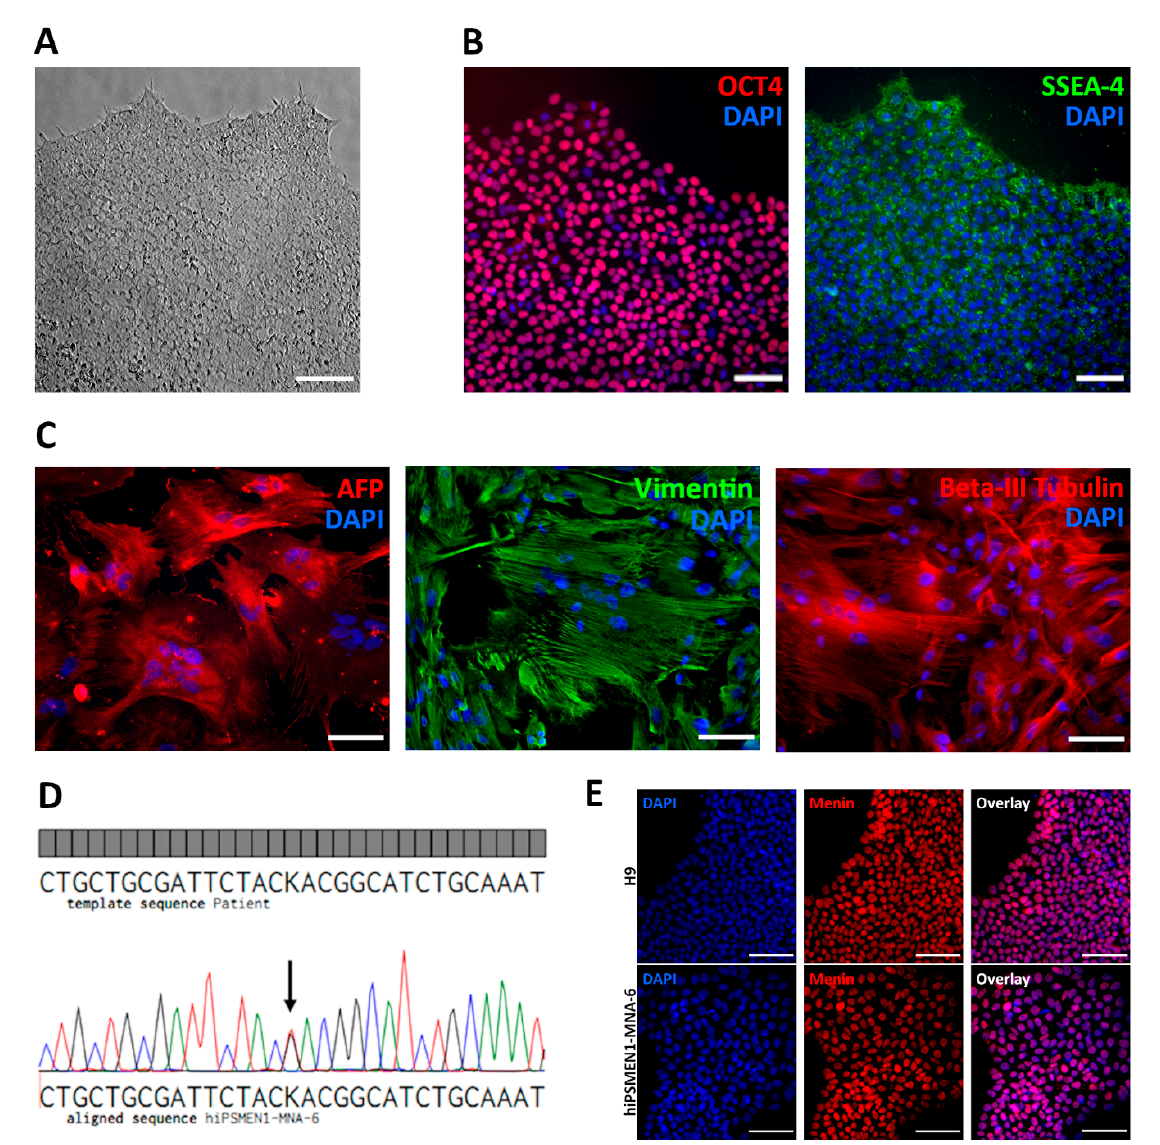
Figure 1. Characterization of hiPSMEN1-MNA-6 cell line derived from a patient with MEN1 syndrome. ( A ) Brightfield microscopy image of iPSC colony showing a typical human embryonic stem-cell-like morphology. Scale bar represents 100 µ m; ( B ) Immunostaining for transcription factor OCT4 (red) and surface antigen SSEA-4 (green) in hiPSMEN1-MNA-6 cells, showing the expression of pluripotent genes. Nuclei were counterstained with DAPI (blue). Scale bars represent 100 µ m; ( C ) Differentiation of hiPSMEN1-MNA-6 cells into all three germ layers (endoderm, mesoderm, ectoderm). Immunostaining for Alpha-fetoprotein, AFP (red), Vimentin (green) and Beta-III-tubulin (red), demonstrating the expression of endodermal, mesodermal and ectodermal markers, respectively. Nuclei were counterstained with DAPI (blue). Scale bars represent 100 μ m; ( D ) Sanger sequencing of the region of interest in the MEN1 gene in patient’s sample (top) and hiPSMEN1-MNA-6 cells (bottom). The analysis revealed that cells sustained a heterozygous mutation c.1252G>T (indicated with a black arrow) in the MEN1 gene; K = T or G according to the IUPAC nucleotide code; ( E ) Immunofluorescence analysis of expression of menin (red) in H9 (upper panel) and hiPSMEN1-MNA-6 (lower panel) cell lines. Nuclei were counterstained with DAPI (blue). Scale bars represent 100 μ m.